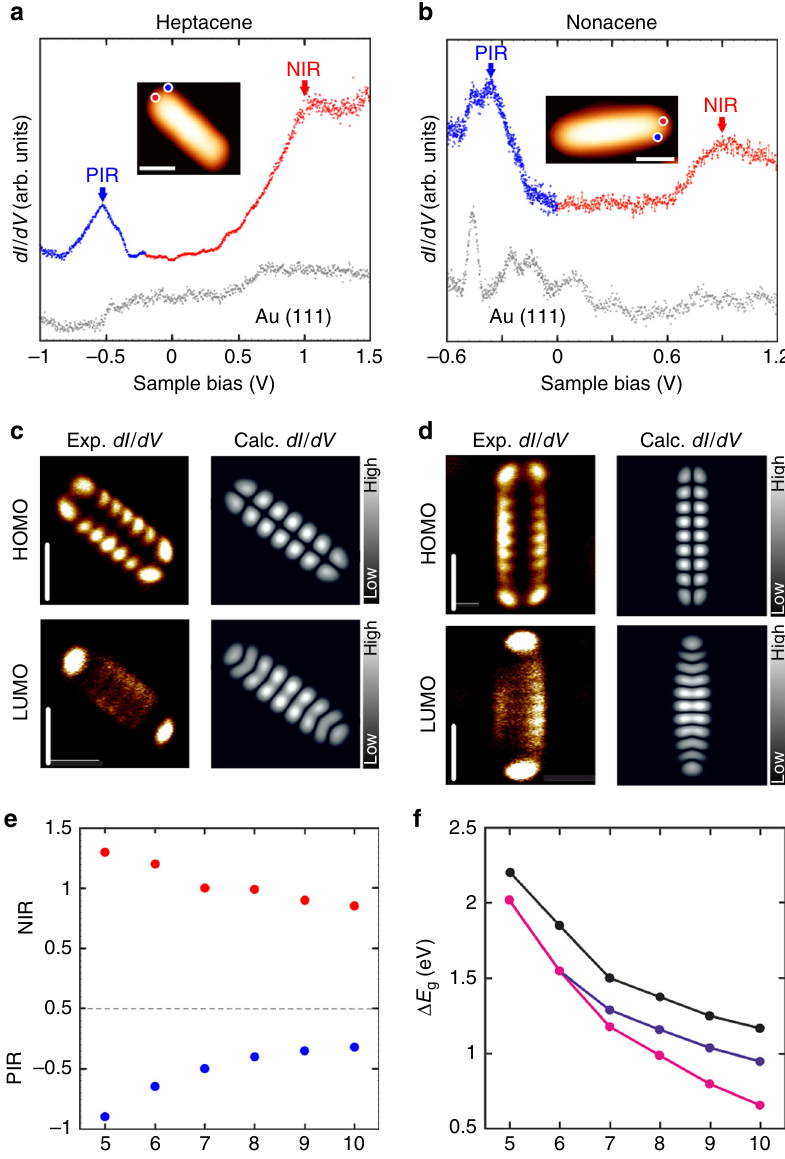
Fig. 5 Electronic structure of heptacene and nonacene. a , b Differential conductance spectra of heptacene ( a ) and nonacene ( b ); the blue curves were acquired at the corner position while the red curves were acquired at the apex of the molecule, as indicated in the constant-current STM images ( a : V = 1 V, I = 40 pA, b : V = 2 V, I = 5 pA) in the inset. c , d Experimental constant-current differential conductance maps at the PIR and the NIR (left), and DFT simulations of the corresponding HOMO for the N + 1 and N − 1 electron system in gas phase (right) of heptacene ( c ) and nonacene ( d ). Current values: 40 pA ( c , top), 80 pA ( c , bottom), 60 pA ( d , top), 90 pA ( d , bottom). e Experimentally determined energy positions of the PIR and the NIR, respectively for acenes from pentacene to decacene on Au(111). Data points for pentacene 36 , hexacene 35 , octacene 44 and decacene 43 are taken from literature. f Experimental electronic gaps (black curve) together with computed quasiparticle energy gaps for the singlet open-shell (blue curve) and closed-shell (pink curve) con fi gurations, including screening effects from the Au(111) substrate. Scale bars: a , b , c : 1 nm, d : 0.5 nm. Prior to recording the dI/dV spectra, tip heights were stabilized with the following set points: − 1 V, 40 pA ( a , blue curve), 1.5 V, 40 pA ( a , red curve), − 0.6 V, 60 pA ( b , blue curve) and 1.2 V, 50 pA ( b , red